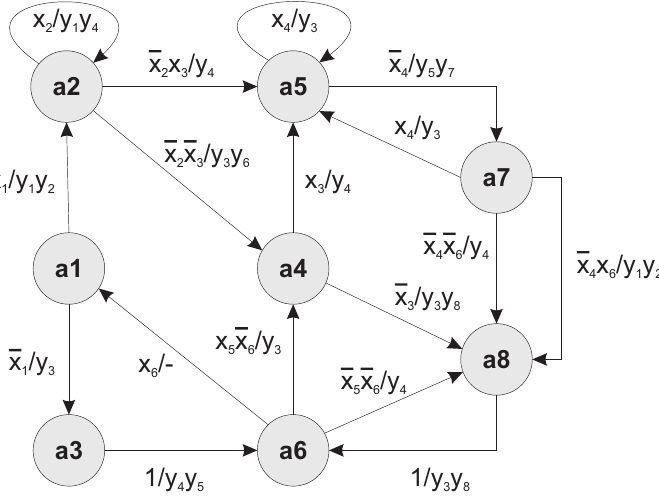
Figure 8. State transition graph of Mealy FSM S 1